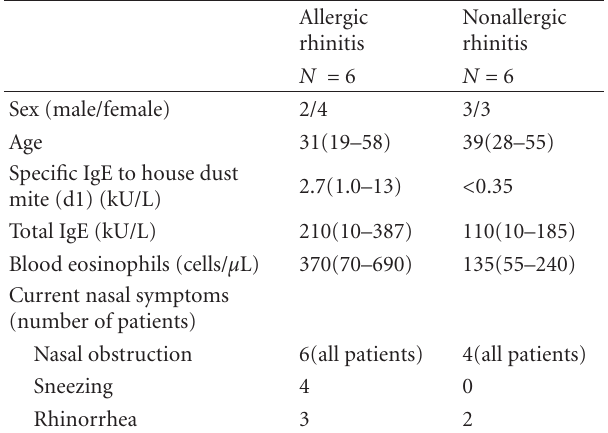
Table 1: Demographic characteristics of allergic and nonallergic